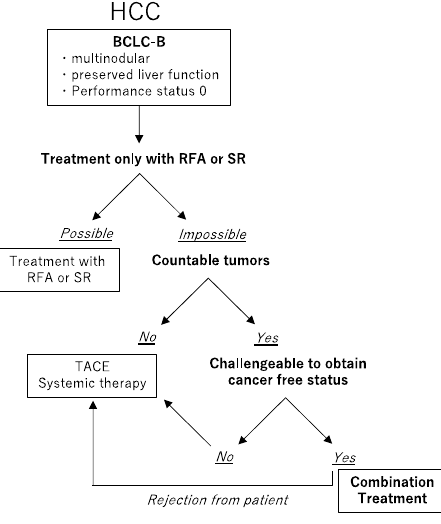
Figure 1. The choice of treatment. For the Barcelona Clinic Liver Cancer (BCLC) B hepatocellular carcinoma (HCC), if radiofrequency ablation (RFA) or surgical resection (SR) can be performed, they should be selected. If not, and if the number of HCCs cannot be counted, transarterial chemoembolization (TACE) or systemic therapy should be selected. If the number of HCCs can be counted, and if the cancer-free status can be challenged, in other words, if sufficient residual liver volume is available after removal of resectable tumors and the remained tumors are suitable for RFA, a combination of SR and RFA should be selected. Patients were properly informed of the treatment options including the guideline-based treatment, and if they did not wish to receive the combination treatment with SR and RFA, they received TACE or systemic therapy as per the guidelines.